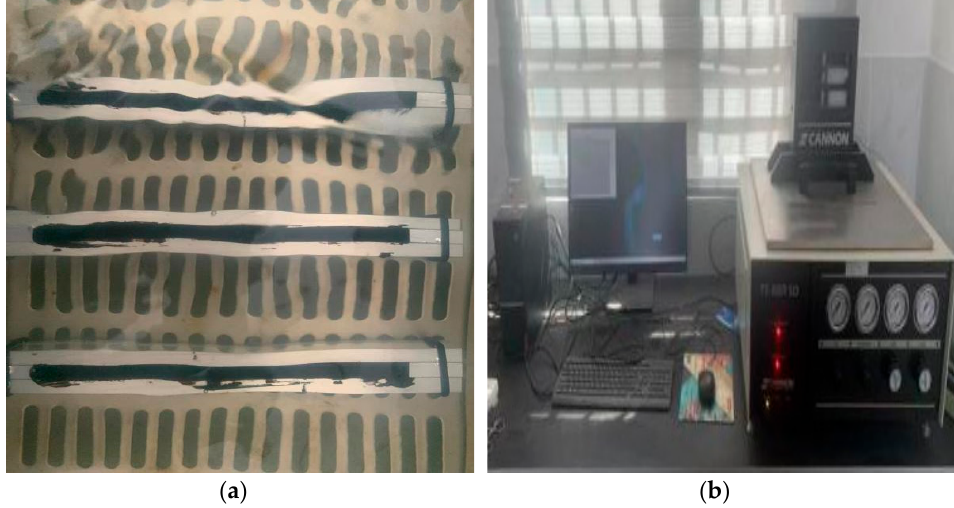
Figure 4. Specimens and BBR instruments: ( a ) BBR test specimens; ( b ) BBR test instruments.